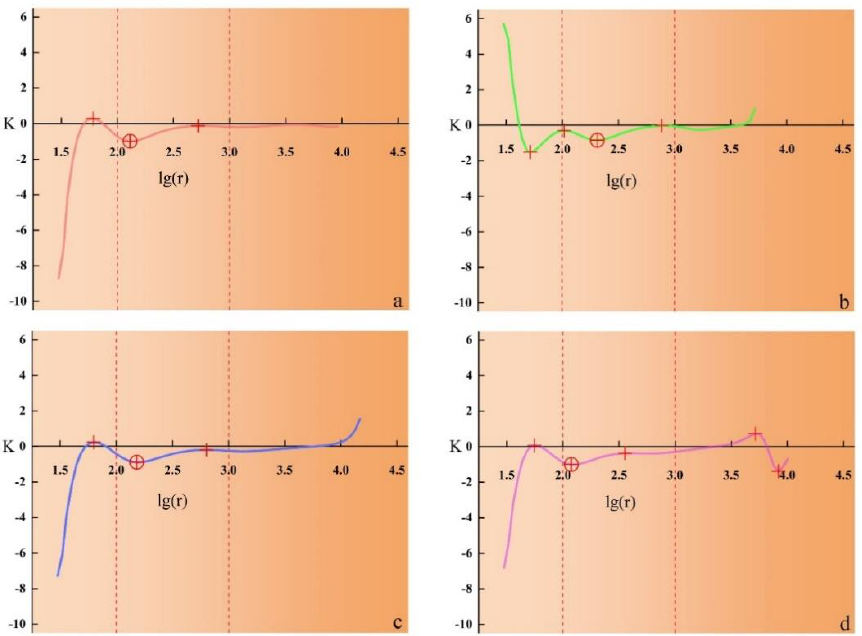
Figure 7. Changes in curvature of urban expansion curves of Guangzhou ( a ), Chengdu ( b ), Nanjing ( c ) and Shijiazhuang ( d ). Table 3. Curvature extremum of expansion curve.